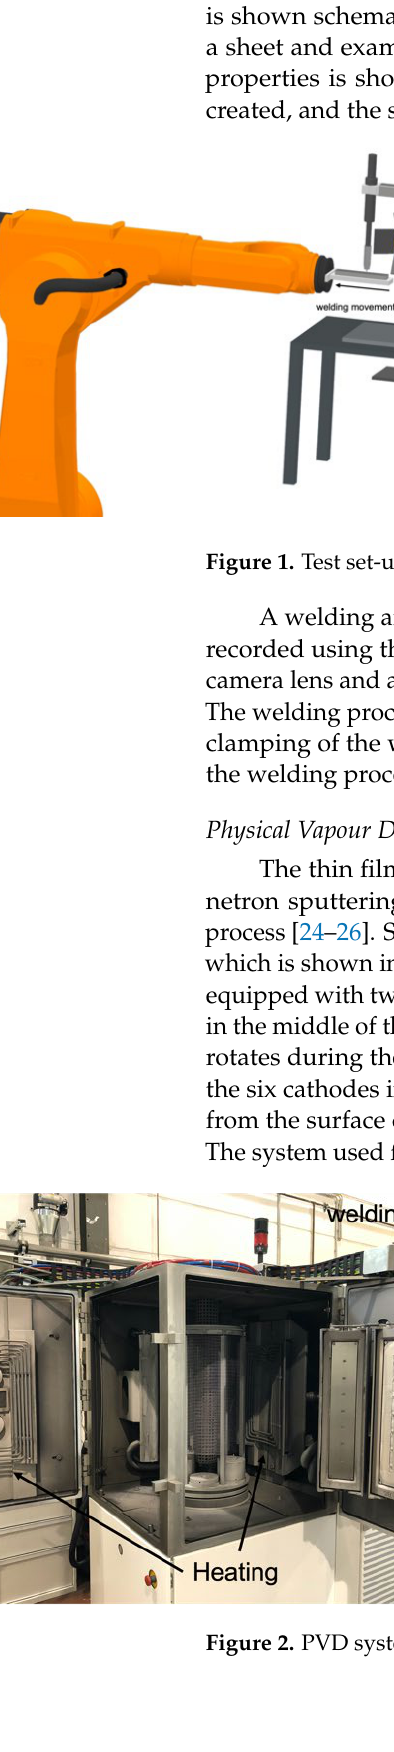
Figure 2. PVD system.